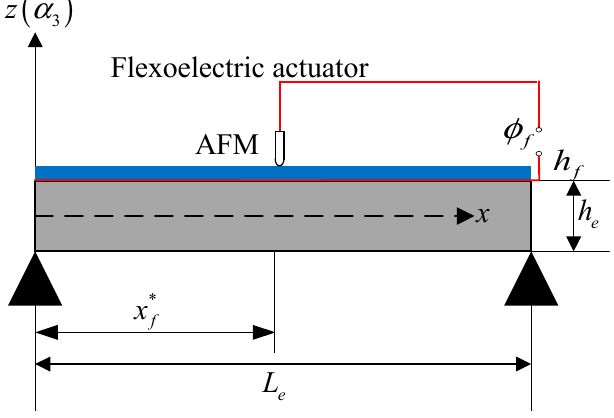
Figure 1. A simply supported beam with flexoelectric actuating.